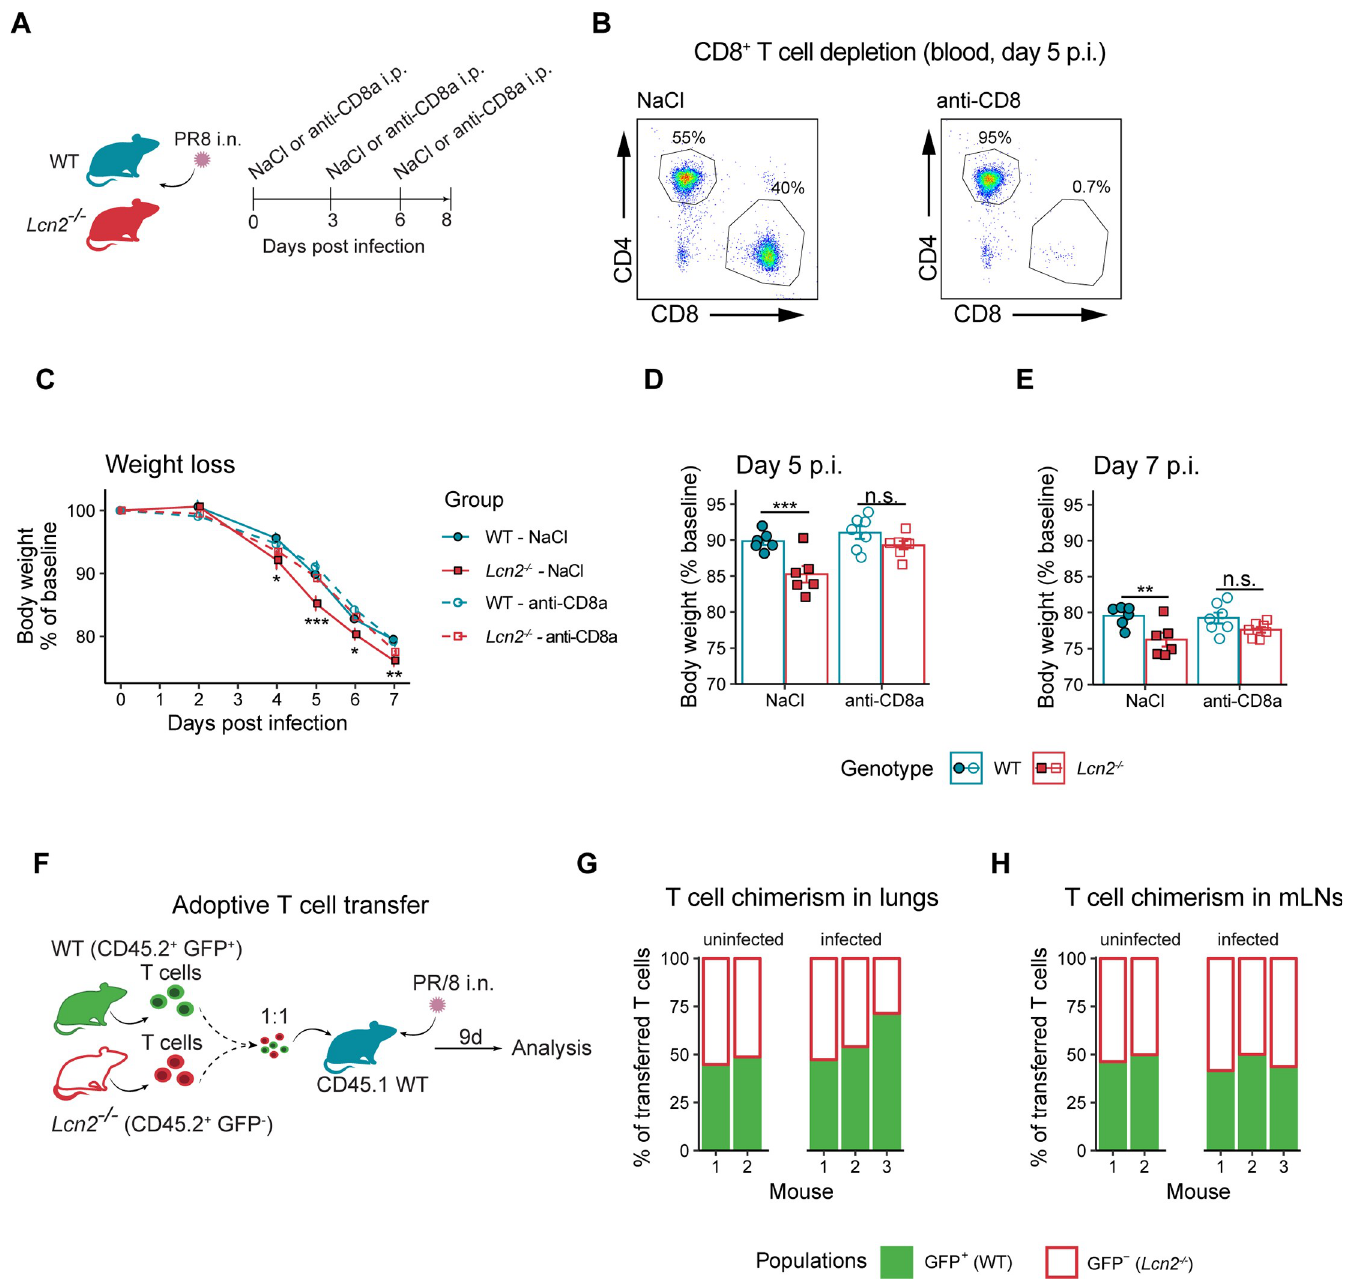
Fig 3. LCN2 protects from excessive weight loss by reducing lung CD8 + T cell numbers but does not affect T cell intrinsic proliferation potential. (A) Experimental layout to assess the contribution of CD8 + T cells to LCN2-related effects on weight loss during influenza infection. WT and Lcn2 -/- mice were treated with anti-CD8a or vehicle (NaCl) on day 0, 3 and 6 post influenza infection (p.i.). Weight loss was monitored and the experiment was stopped meeting pre-defined endpoint criteria. (B) Representative FACS plots illustrating CD8 + T cell depletion after anti-CD8a treatment on day 5 post infection/start of treatment. Cells are pre-gated single, live, CD45 + , CD19 - and CD3 + cells. (C) Weight curves after influenza infection. Asterisks below the curves denote statistical significance for the comparison between NaCl-treated WT vs . Lcn2 -/- mice, asterisks above the curve for the comparison between anti-CD8a treated mice. n = 6–7 per group (D, E) Relative body weight (compared to baseline day 0) on day 5 (D) and day 7 (E) after influenza infection. (F) Experimental layout to assess the proliferative potential of WT and Lcn2 -/- T cells. 50:50 ratio of splenic WT (GFP + ) and Lcn2 -/- (GFP - ) T cells were transferred to CD45.1 + mice and infected with PR/8. CD45.2 + GFP + and CD45.2 + GFP - T cells (indicative of transferred WT or Lcn2 -/- genotype, respectively) were assessed nine days later in lungs and mesenteric lymph nodes (mLNs). (G, H) Relative abundance of GFP + (WT) and GFP - ( Lcn2 -/- ) cells among CD45.2 + CD3 + T cells derived from lungs (G) and mLNs (H) 9 days post infection. Columns represent samples collected from individual mice. Bar diagrams and error bars (C-E) show group means +/- SEM. Statistical significance for comparisons between genotypes for (C-E) was assessed using estimated marginal mean comparison after 2-way ANOVA. � p < 0.05, �� p < 0.01, ��� p < 0.001.